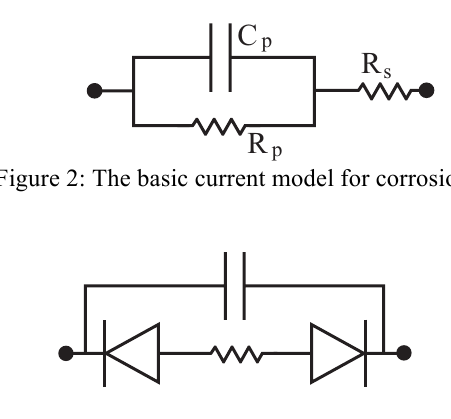
Figure 3: The rusty bolt effect – model.